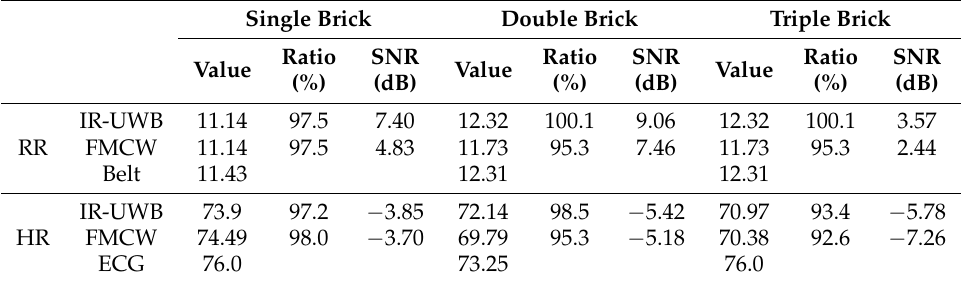
Table 9. RR and HR Results of Penetration Comparisons with Multiple Bricks. Single